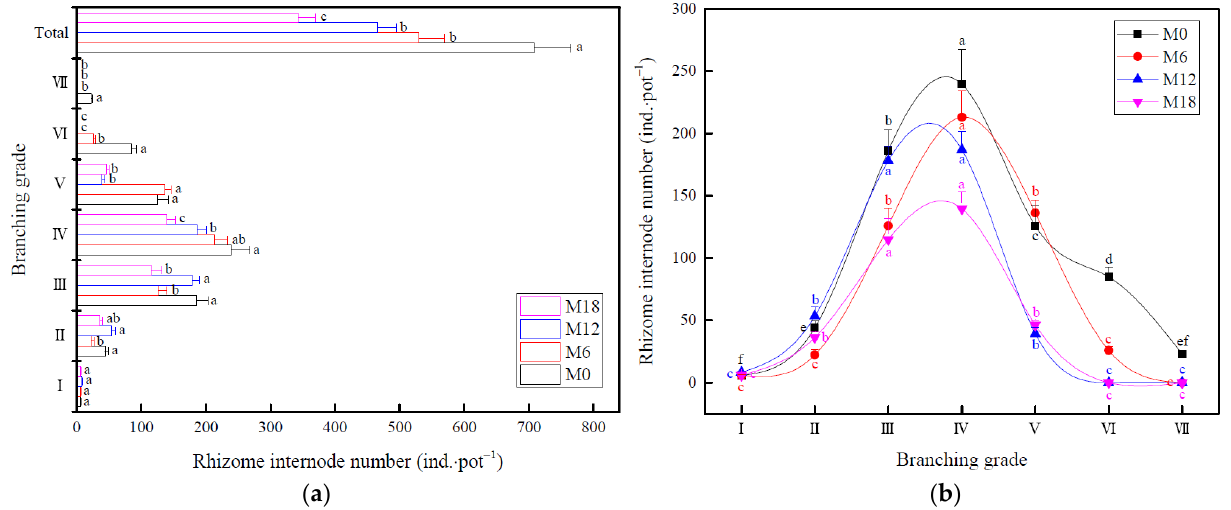
Figure 5. Rhizome internode number. ( a ) Quantitative characteristics of rhizome internode; ( b ) var ‐ iation trend of rhizome internode number. Different letters indicate significant differences ( p < 0.05).